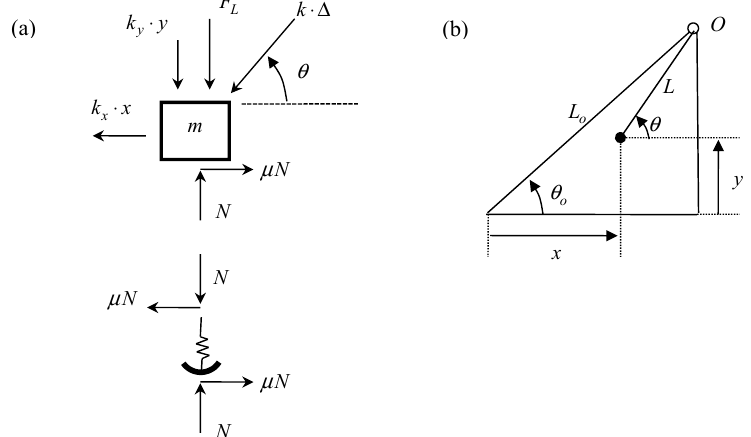
Figure 1. Description of a spring-mass model. The inclined angle θ is variable.